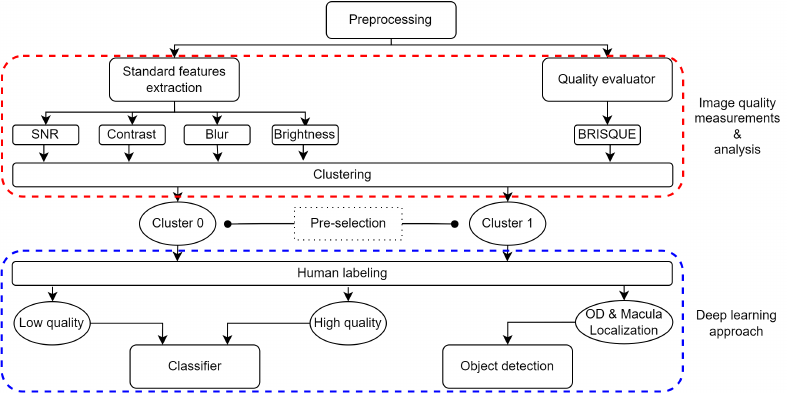
Figure 1. Workflow diagram: pre-processing, analysis, labeling, classification, and detection. The suit- able decision is based on quality classification (by a CNN) and RFI anatomical feature